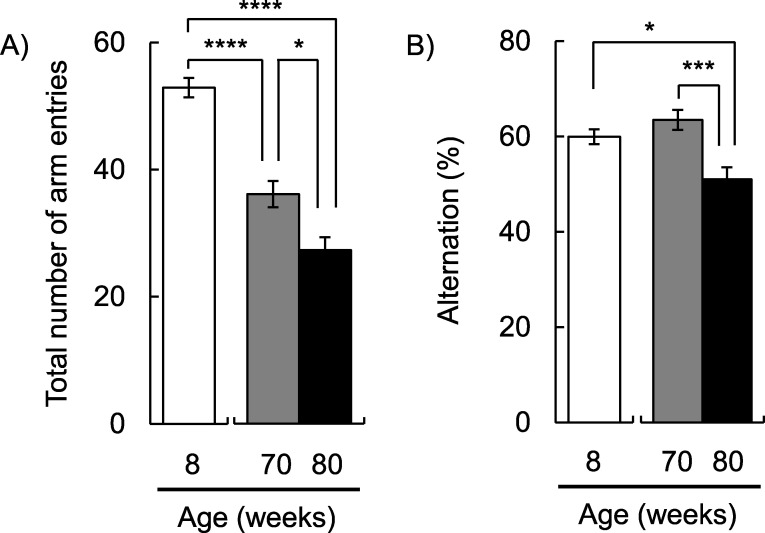
Short-term memory changes due to aging.(A) The total number of arm entries and (B) the alteration ratio are shown (8-week-old mice for n = 25, 70-week-old mice for n = 21, 80-week-old mice for n = 14). The total number of arm entries and alternation ratio significantly decreased with age (F(2,57) = 44.0, p < 0.0001 for the total number of arm entries, F(2, 57) = 7.77, p < 0.001 for the alternation ratio; one-way ANOVA). * p < 0.05, *** p < 0.001 and **** p < 0.0001 (Tukey posthoc test).